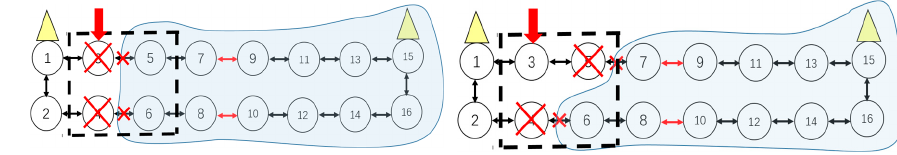
Figure 9. Situation of cluster adjustment.